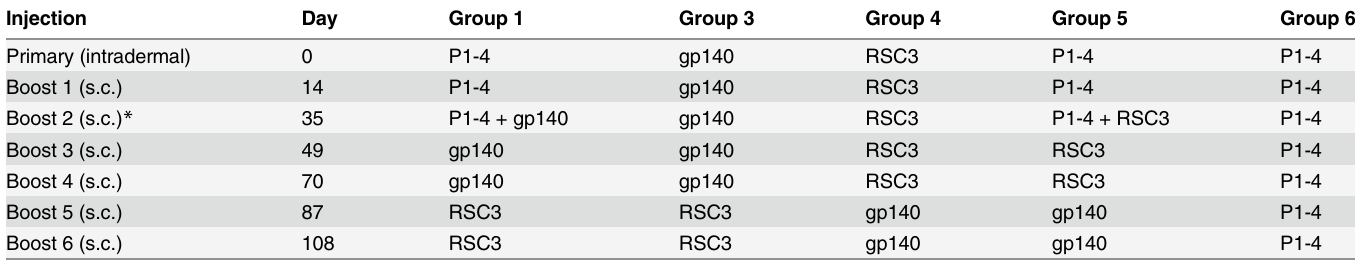
Table 1. Protocol for rabbit immunization.